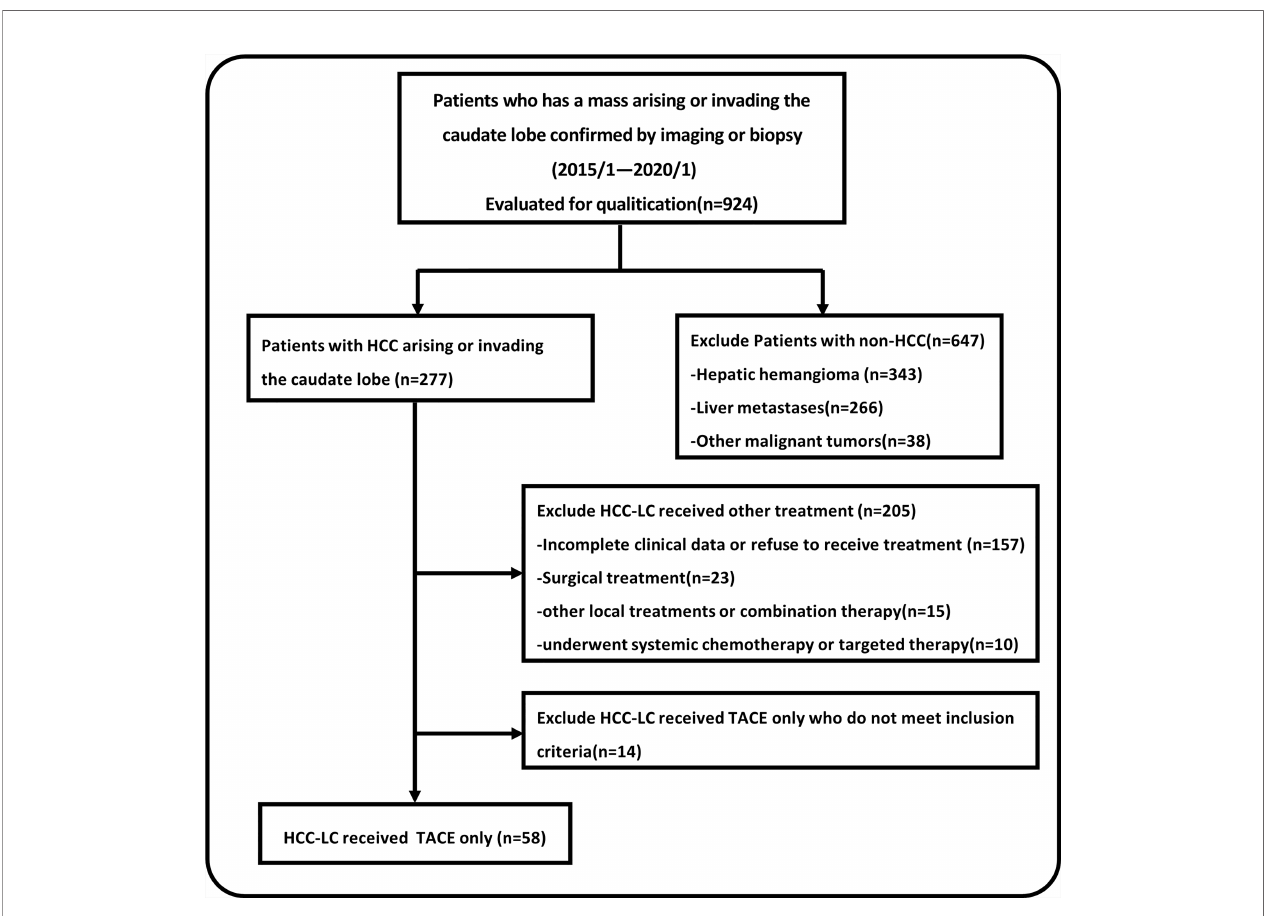
FIGURE 1 | Patient enrolment and categorization fl ow